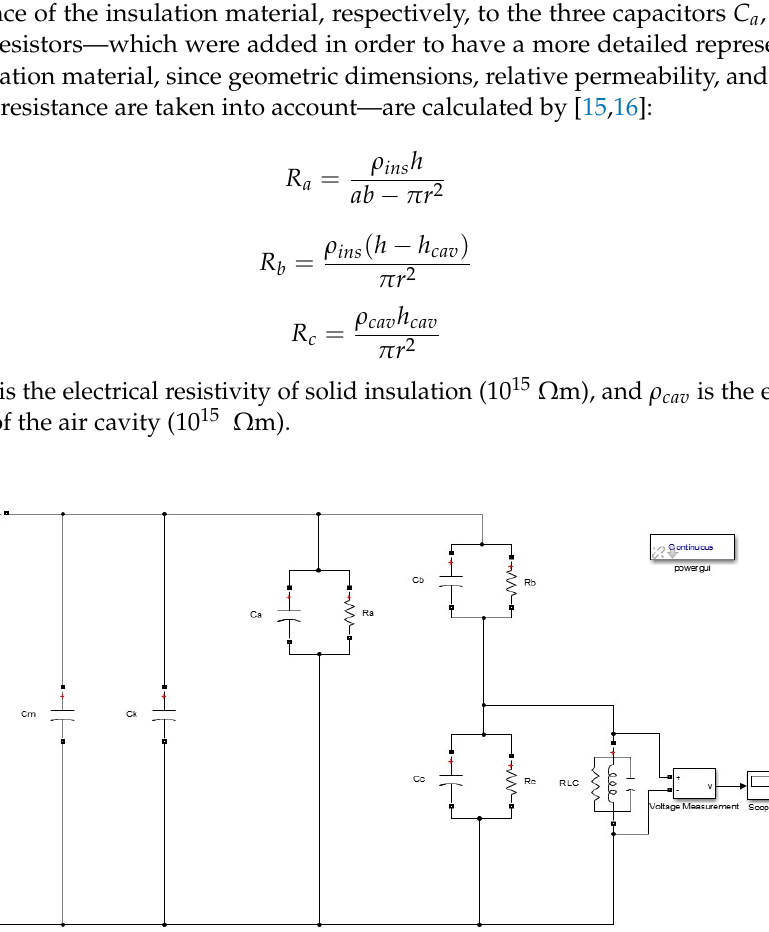
Figure 13. PD Activity for ER, 5 kV, h, r. Figure 14. PD Activity for ER, 5 kV, h, 2 r.